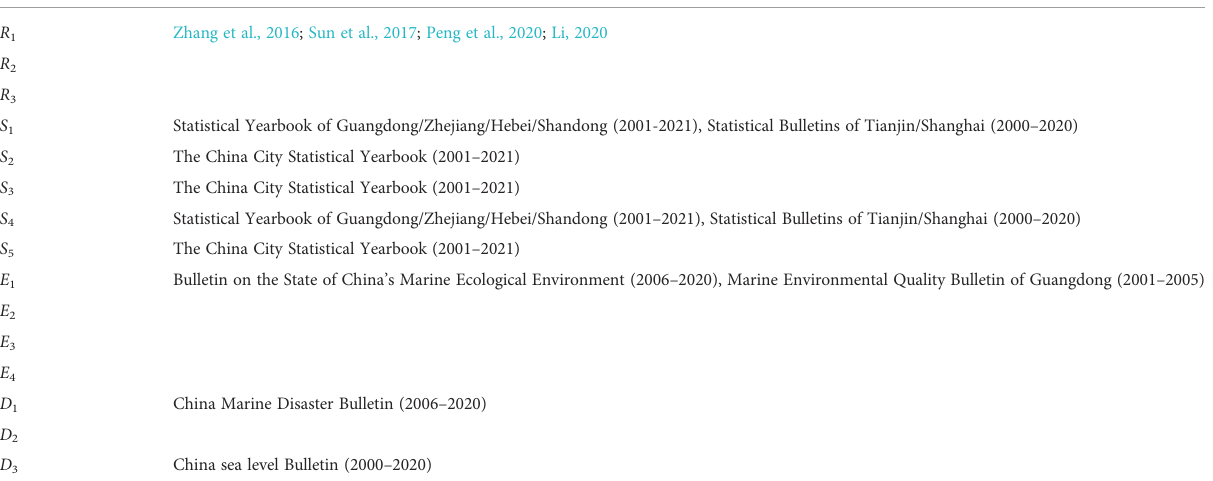
TABLE 2 Data sources of the indicators for assessing the resilience of the bay area.